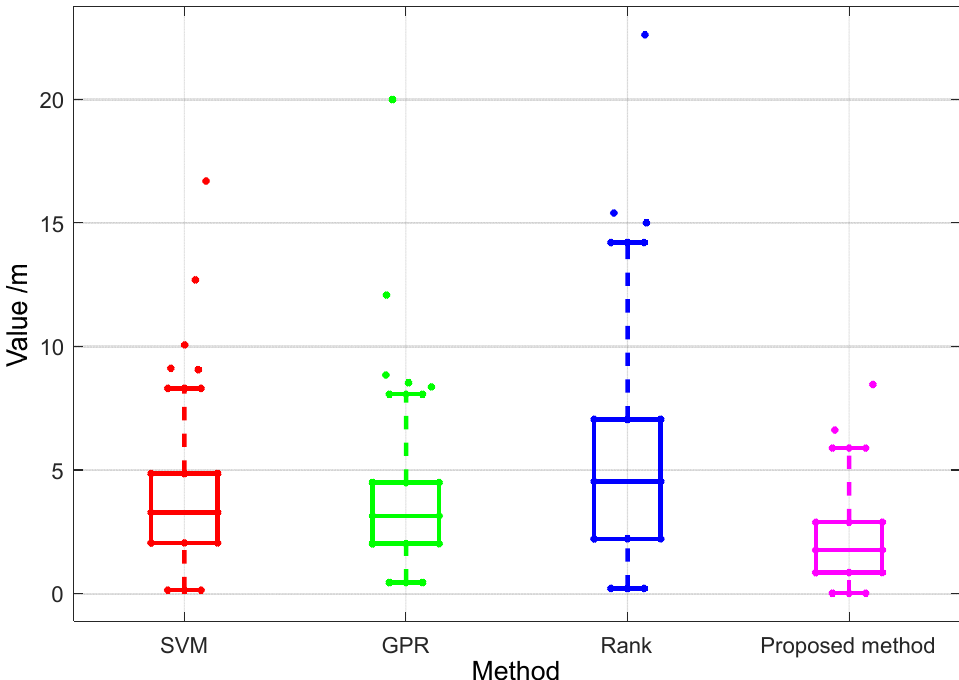
Figure 14. Positioning effects of SVM, GPR, rank and the proposed method.